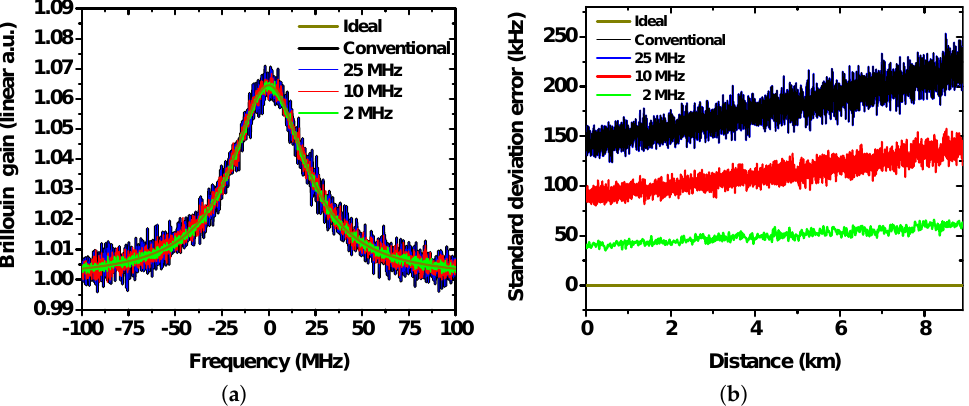
Figure 2. ( a ) Reconstructed Brillouin gain spectrum (BGS) (resolution 0.1 MHz) at the near end of the fiber and ( b ) standard deviation error after applying RF filtering with different bandwidths in the